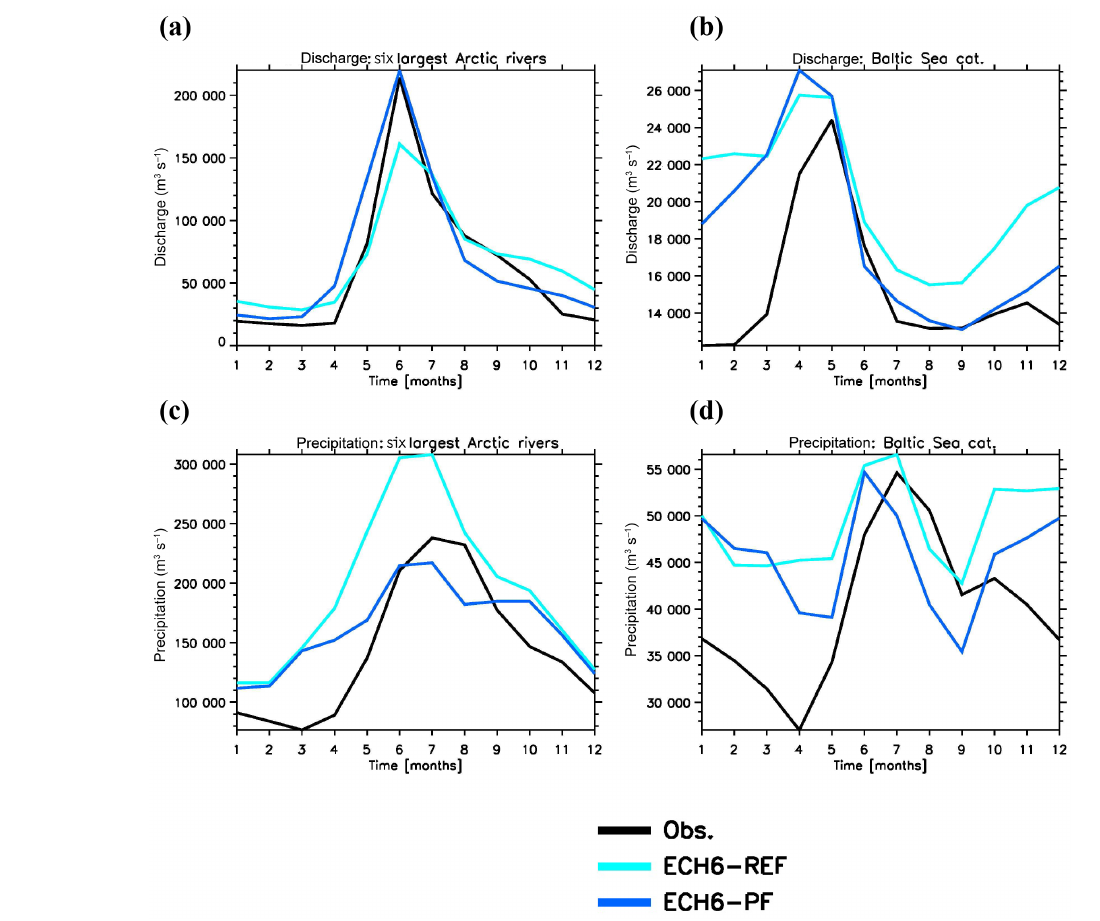
Figure 5. Mean monthly climatology (1989–2009) of discharge (upper panels) and precipitation (lower panels) over the six largest Arctic river catchments (left column) and the Baltic Sea catchment (land only, right column). Observations comprise climatological observed discharge and WFDEI precipitation,